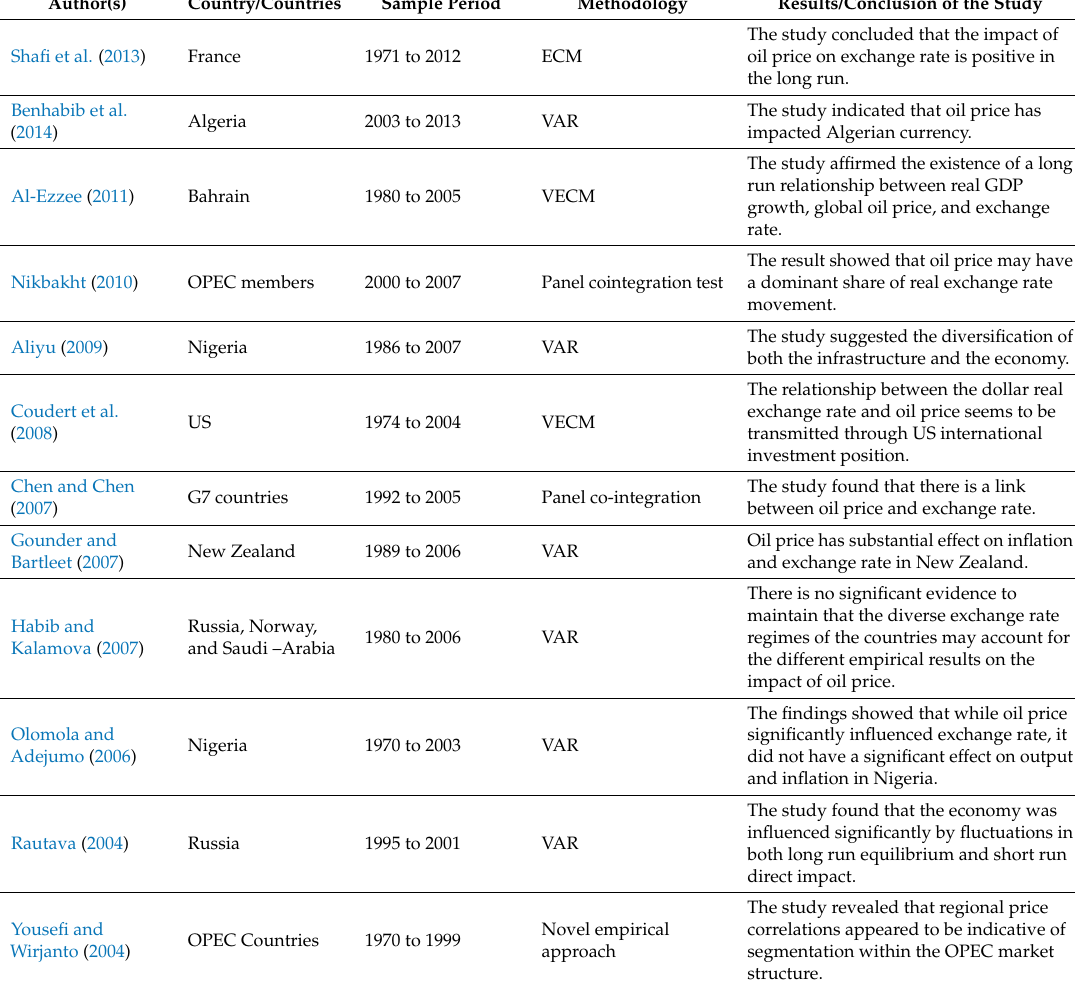
Table 3. Empirical evidence on oil price and exchange